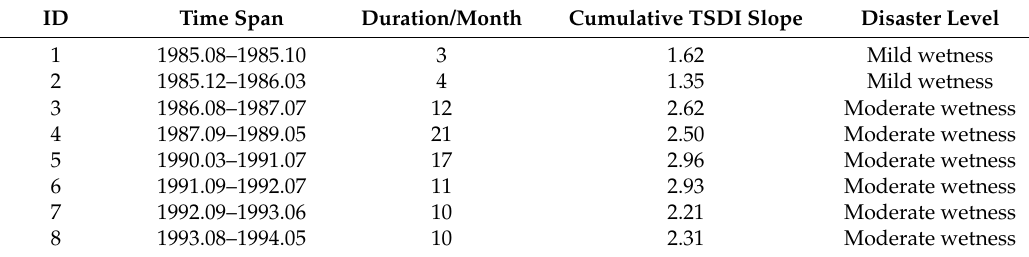
Table 5. Statistics of disaster events identified by the Table 5 . Statistics of disaster events identified by the TSDI.